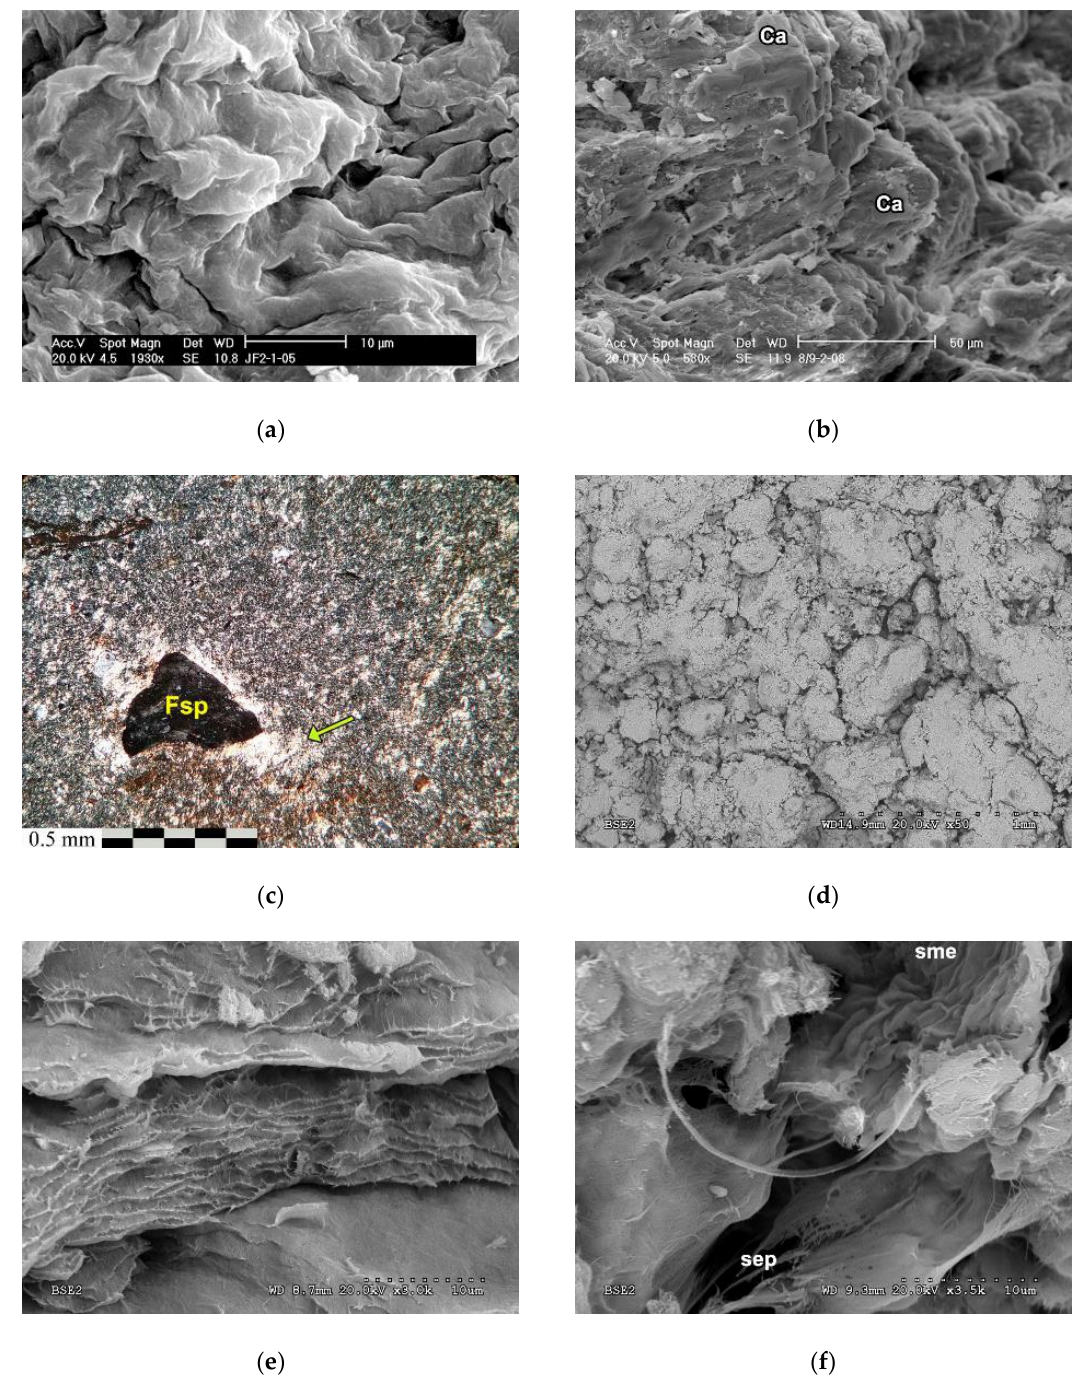
Figure 6. ( a ) Laminar-turbulent microfabric of smectite (JF-01, lithofacies I.1-A) (SEM, SE); ( b ) calcite crystals (Ca) inserted between Mg-clay laminae (BAT8/9-2, lithofacies I.1-A); ( c ) K-feldspar (Fsp) grain showing a birrefringent fabric of skelsepic type (crossed polars) (BA-10, lithofacies I.1-B); ( d ) skeletal microfabric composed of smectite-rich intraclasts (BS2I-2, lithofacies I.1-C) (SEM, BSE); ( e ) laminar microfabric of sepiolite (BS2I-8, lithofacies I.2-A) (SEM, BSE); and ( f ) sepiolite bundles with fibers infilling porosities (sep) near crumpled smectite aggregates (sme) (ST-10, lithofacies I.2-A) (SEM, BSE). Mudstone